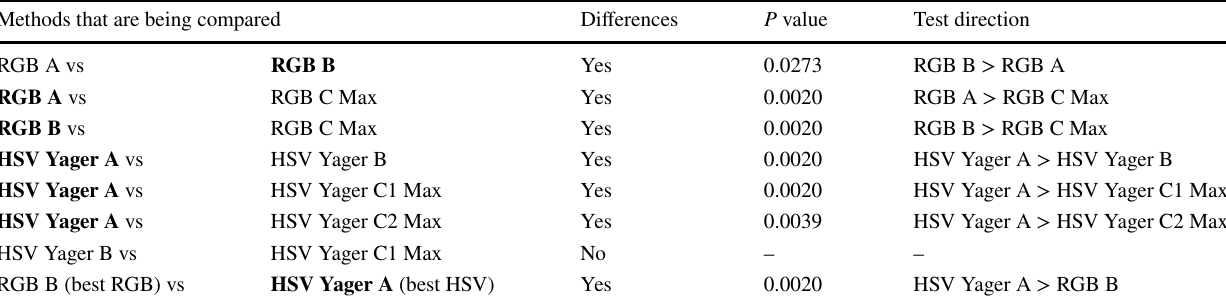
Bold value indicate method reached the highest